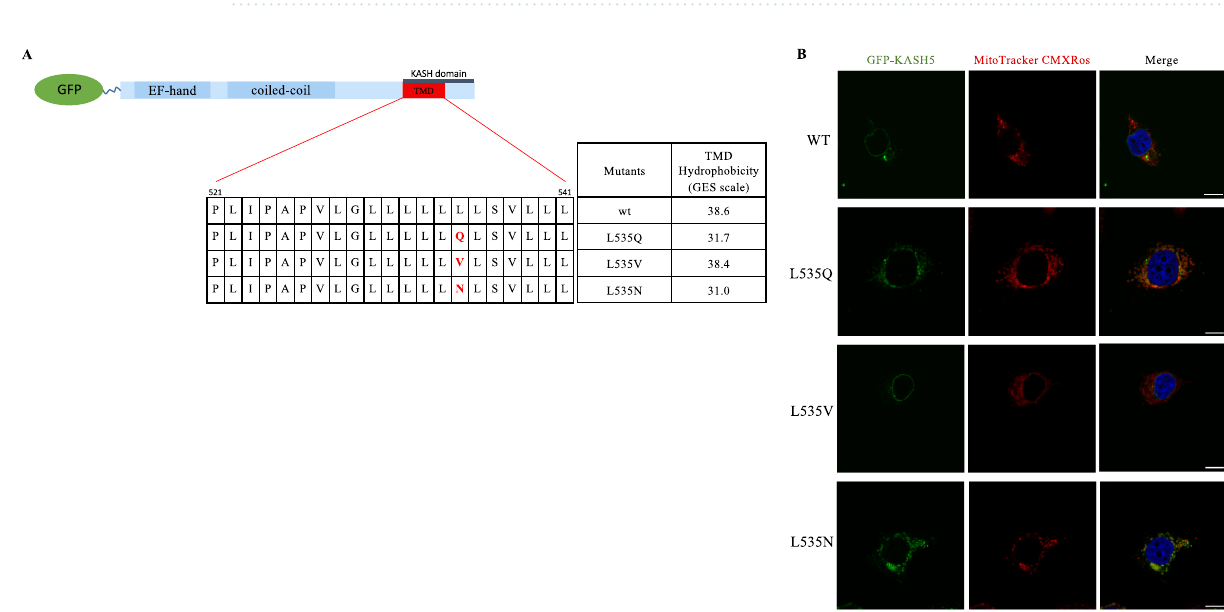
Figure 4. Hydrophobicity of the transmembrane domain alters KASH5 protein localization. ( A ) Schematic representation of KASH5 TMD indicating the different amino acid substitution at the position 535 (V, valine; Q, glutamine; N, asparagine). Using the GES scale to calculate the hydrophobicity, the L535V and L535N substitutions mimic the hydrophobicity of the TMD of the wild-type and L535Q KASH5, respectively. ( B ) MCF-7 cells transfected with a GFP-tagged version of wild-type or variant KASH5 and treated with MitoTracker Red CMXROS to stain the mitochondria. Both wild-type and L535V KASH5 localize at the nuclear envelope while both L535Q and L535N localize at the mitochondria. This experiment was repeated four